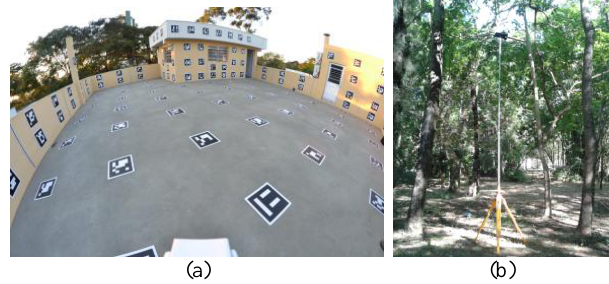
Figure 3. (a) Example of a fisheye image used in the 3D calibration field; (b) Camera positioned among trees to collect vertical images.